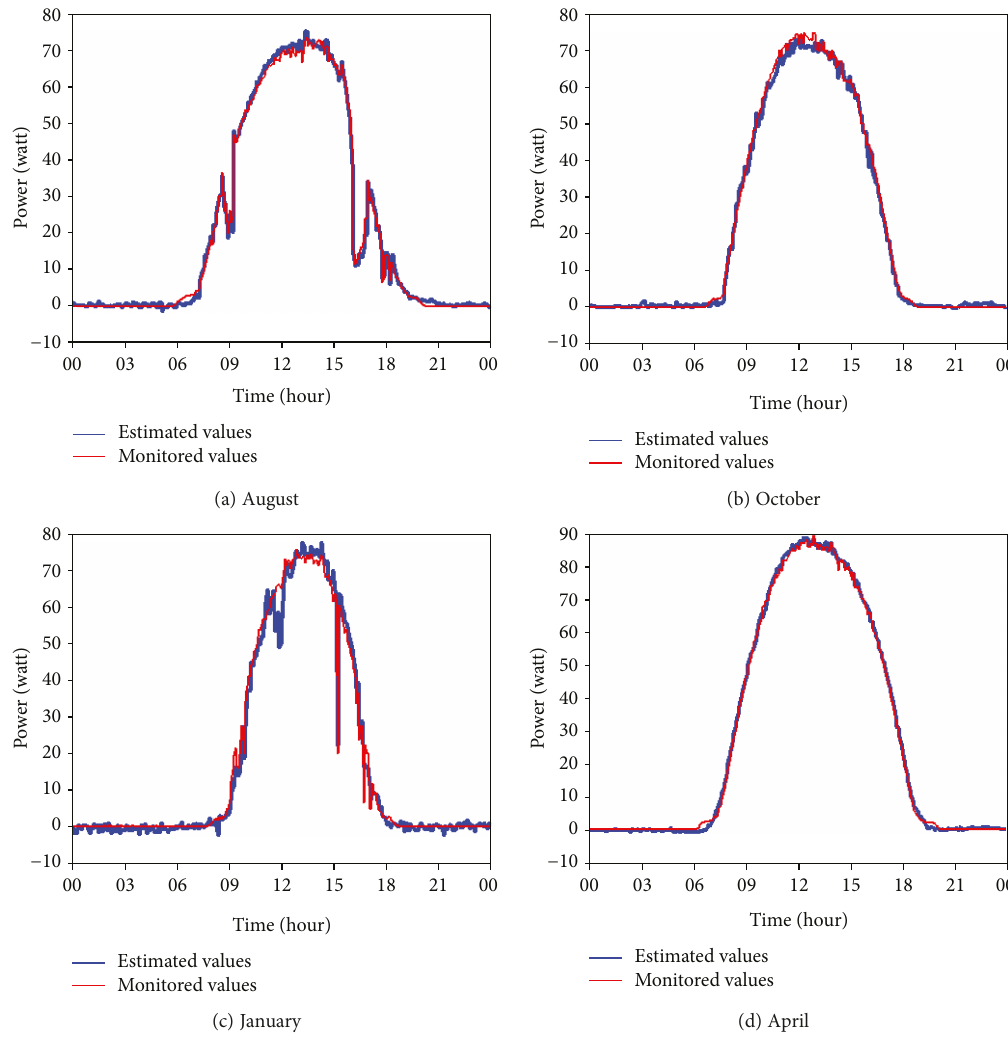
Figure 7: Sample estimation graphs for Sanliurfa. Table 4: Meteorological data statistics of provinces. Meteorological data